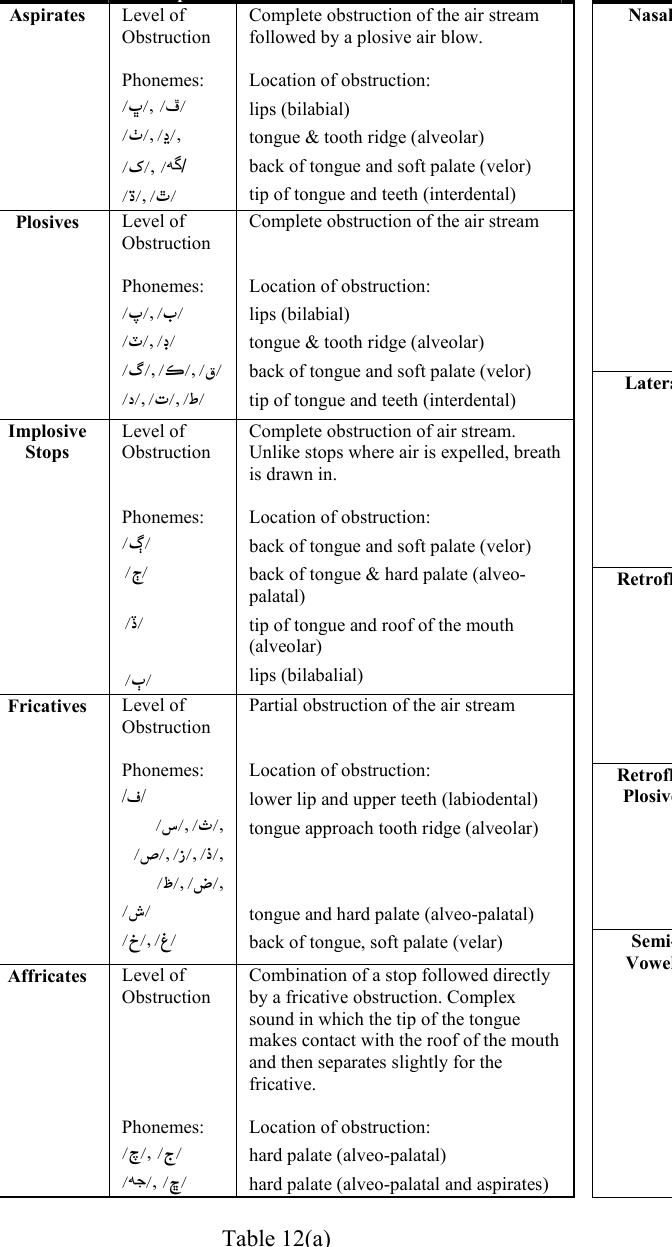
Table 11: Manners of Articulation for all Sindhi Consonant and Semi-vowel Phonemes